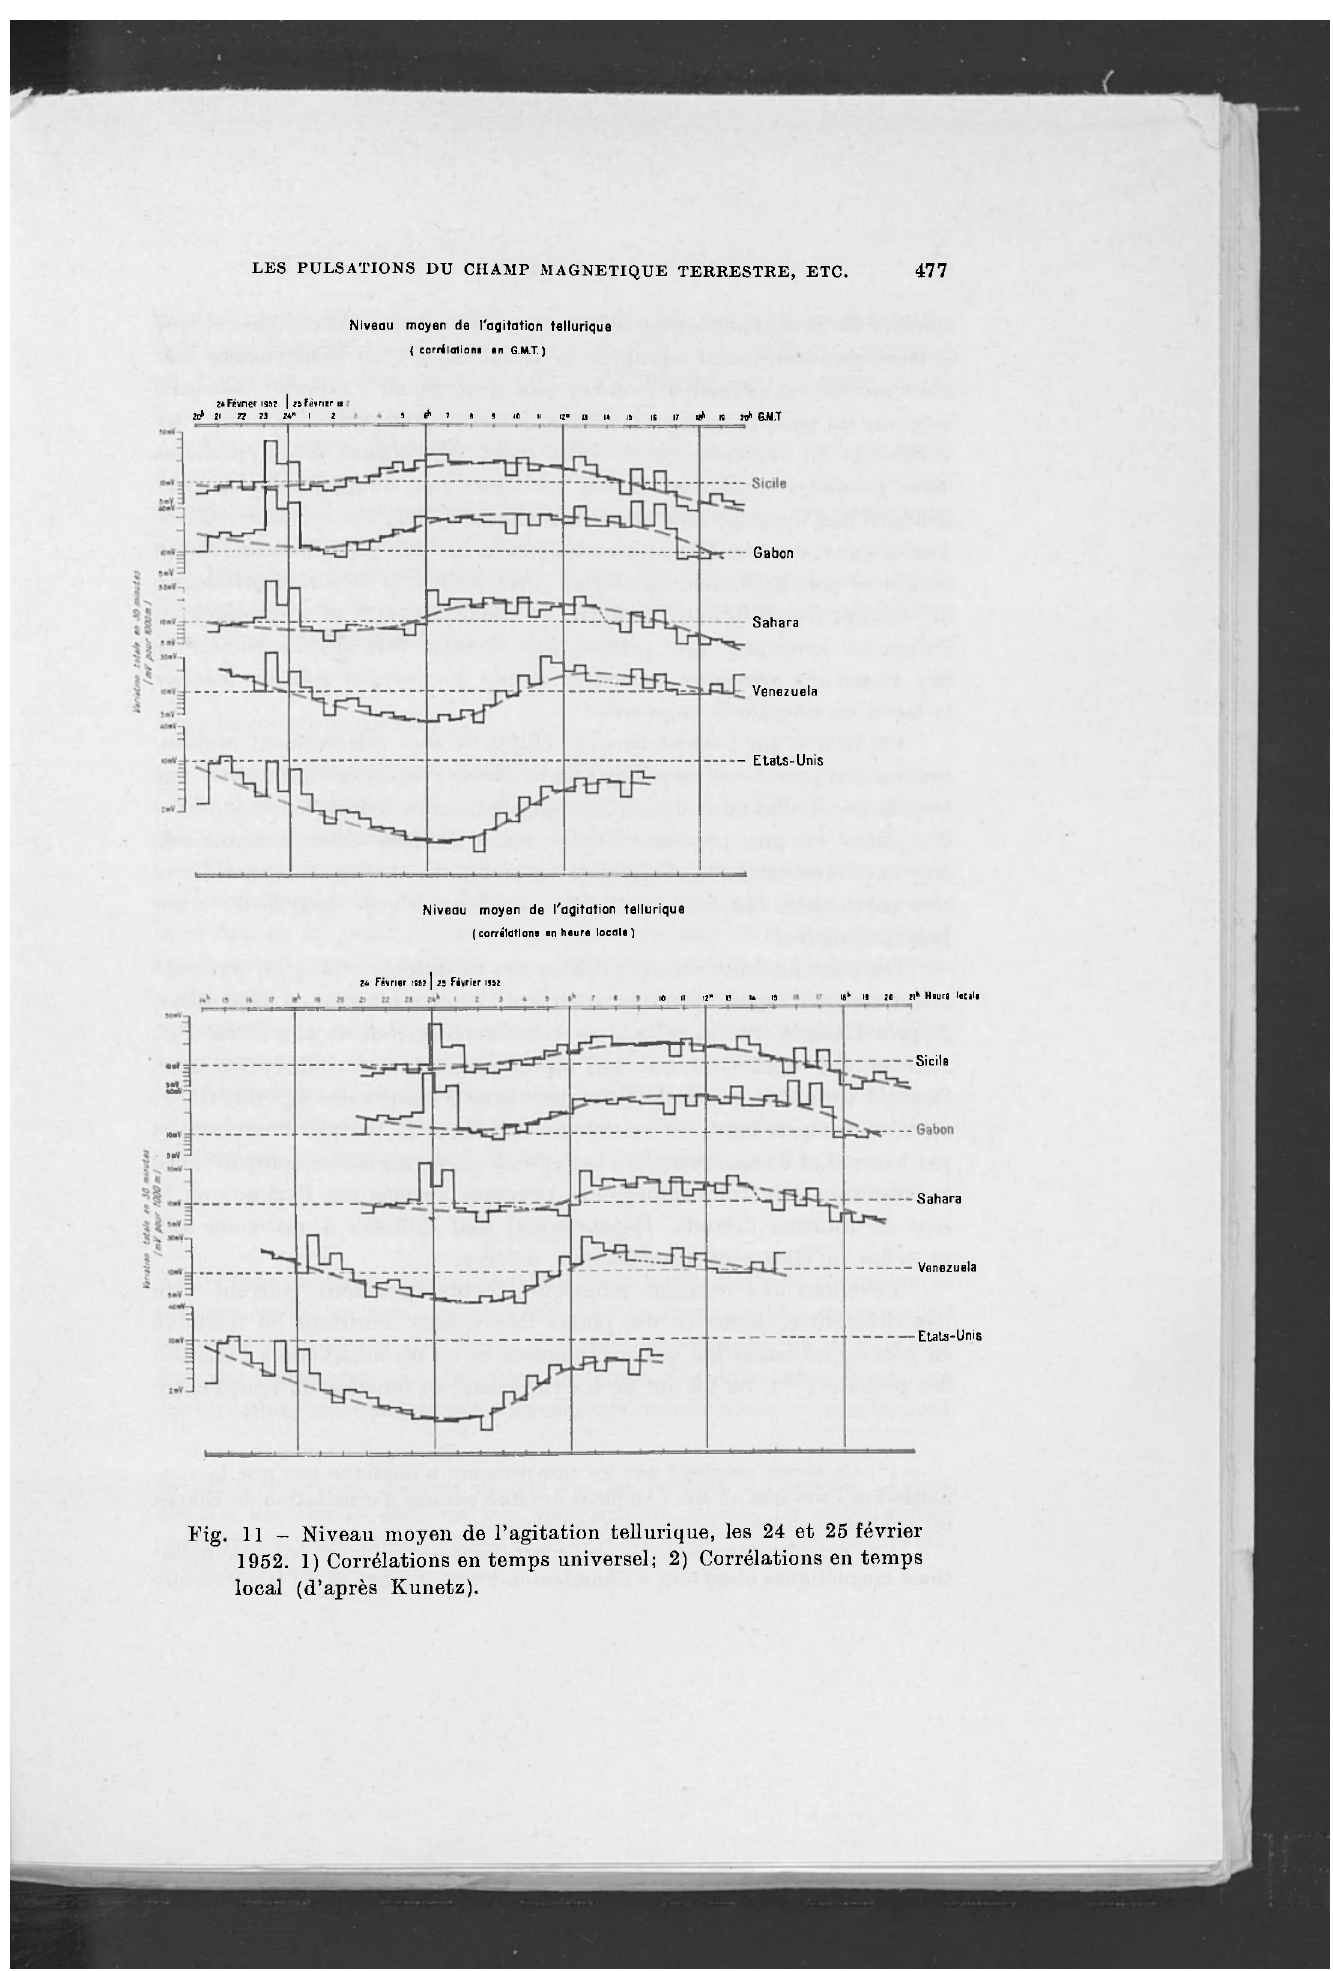
Fig. 11 - Niveau moyen de l'agitation tellurique, les 24 et 25 février 1952. 1) Corrélations en temps universel; 2) Corrélations en temps locai (d'après